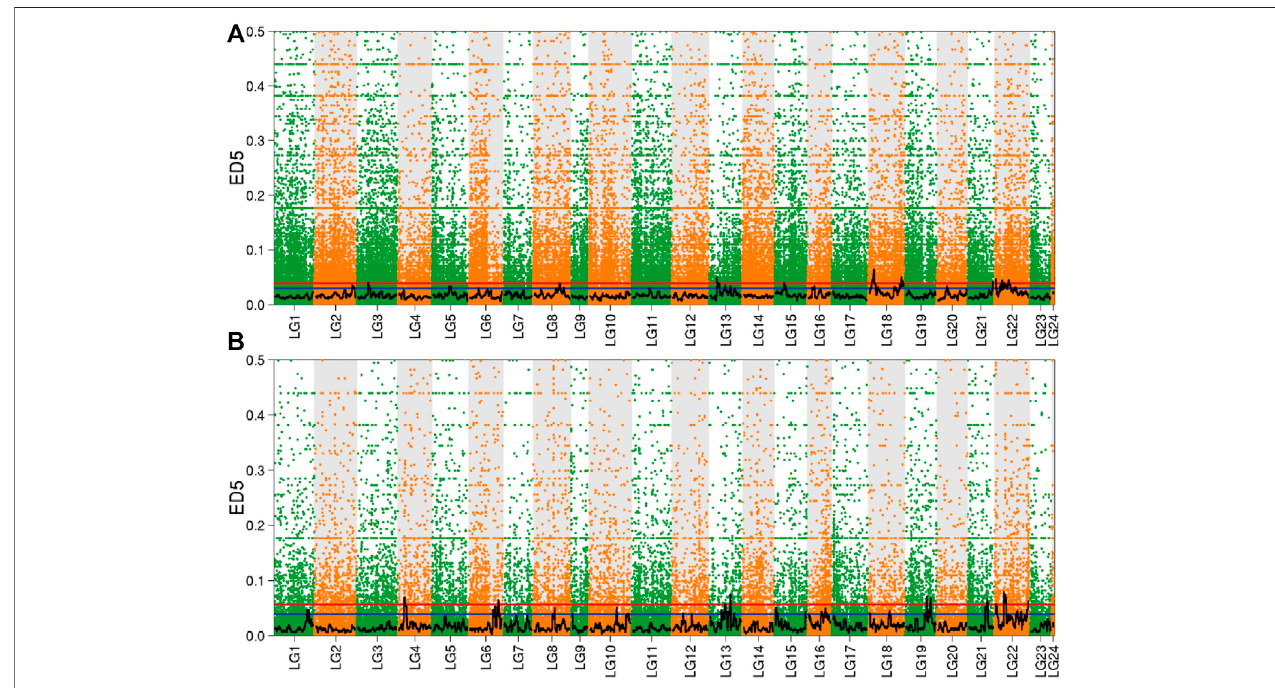
FIGURE 5 | Distribution of ED value in the brain and liver. Note: (A) Brain; (B) Liver; The red line in the fi gure is the 99% quantile line, and the blue line is the 95% quantile line.